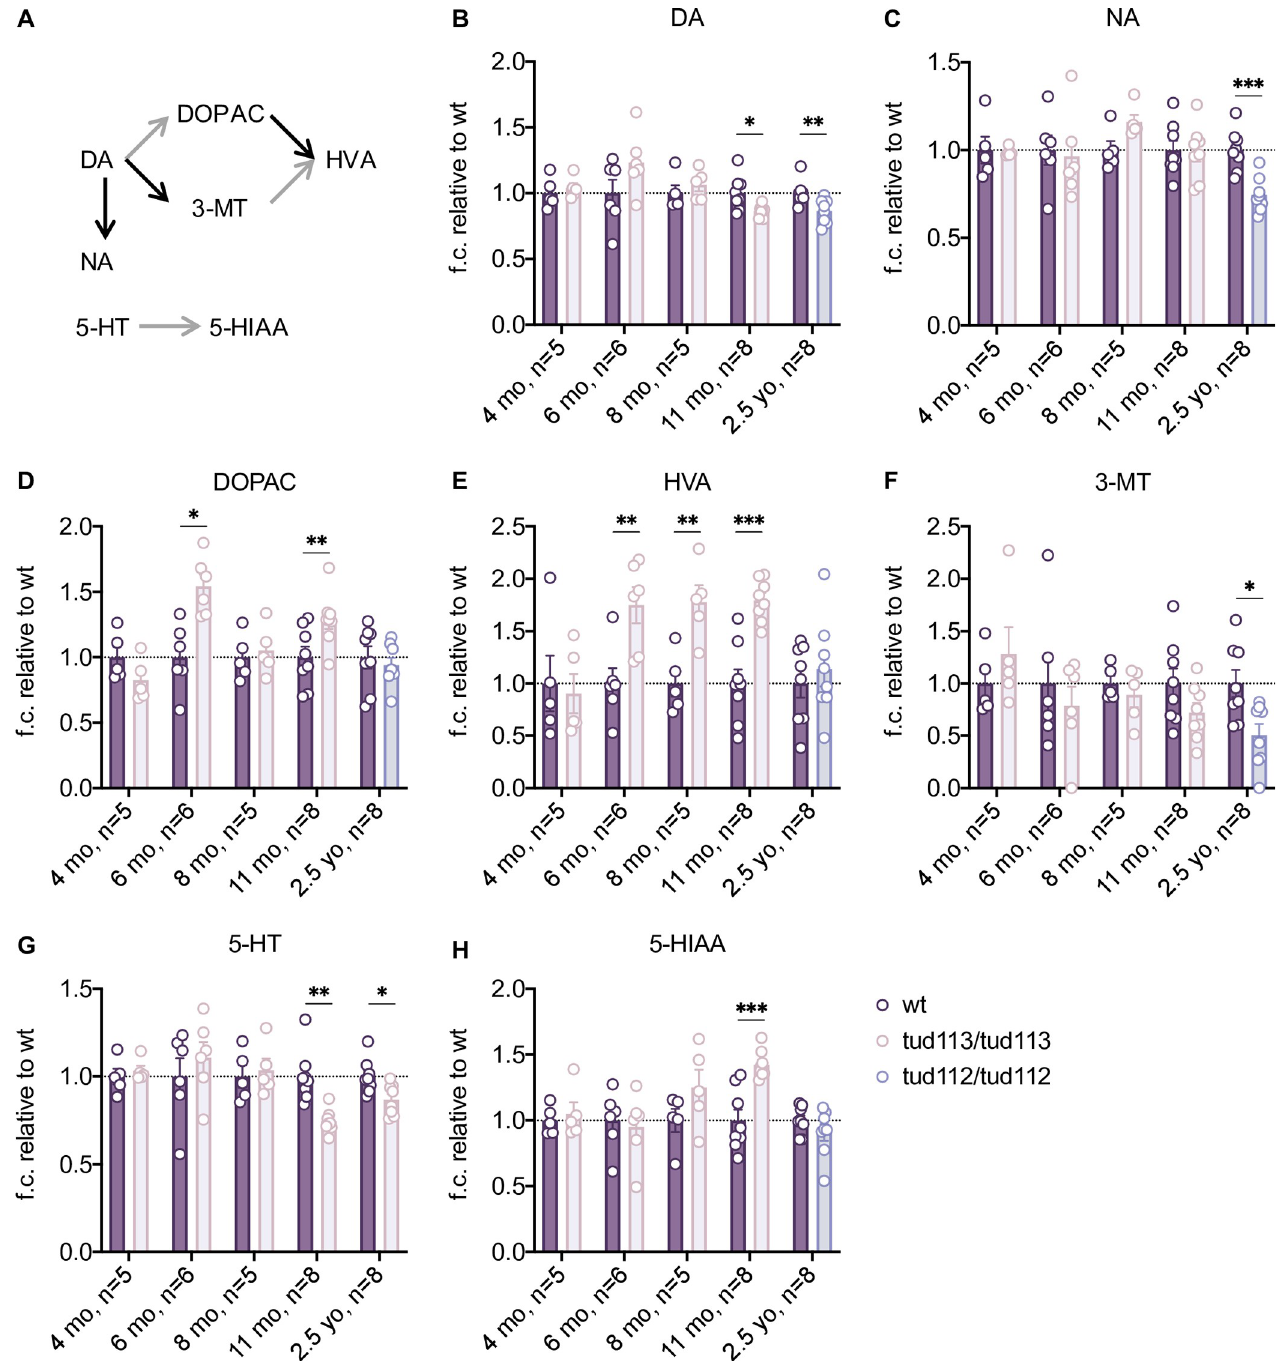
Fig 4. Age-dependent perturbation of monoamine catabolism in the mzLrrk2 brain. (A) Simplified scheme of the catabolism of dopamine and serotonin in the zebrafish brain. Each arrow represents a distinct enzymatically-catalyzed step. Grey arrows indicate the reactions catalyzed by the combined action of monoamine oxidase (MAO)/aldehyde dehydrogenase. Abbreviations: 3-MT, 3-methoxytyramine; 5-HIAA, 5-hydroxyindoleacetic acid; 5-HT, serotonin; DA, dopamine; DOPA, 3,4-dihydroxyphenylacetic acid; HVA, homovanillic acid; NA, noradrenalin. (B-H) Levels of biogenic amines and their catabolites in the brain of adult maternal-zygotic tud113 fish at different ages: 4, 6, 8, and 11 months, and age-matched controls; data from 2.5-year-old (yo) maternal-zygotic tud112 fish, and age-matched controls, are also included. Plots represent means ± s.e.m. Statistical analyses: (B: 4–6 mo, B: 11 mo, C: 6 mo, C: 11 mo, C: 2.5 yo, D-G: 6–11 mo, G: 2.5 yo, H) two-tailed Student’s t -test; (B: 8 mo, B: 2.5 yo, C: 4 mo, C: 8 mo, G: 4 mo) two-tailed Mann-Whitney’s U -test.